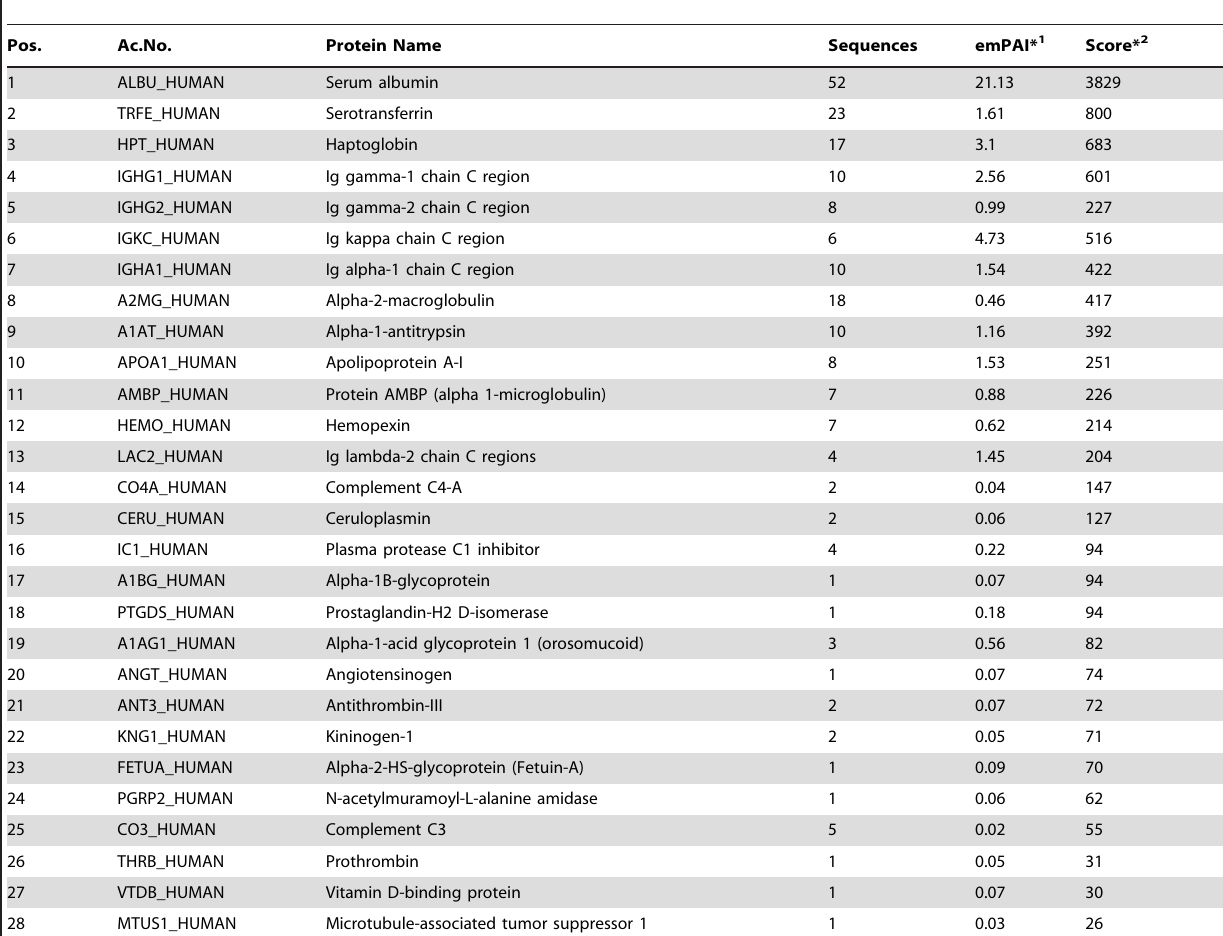
Table 3. Liquid chromatography–tandem mass spectrometer (LC/MS-MS) of samples from the patients with A3G4 and the search result through NCBInr and Swiss-Prot database performed by